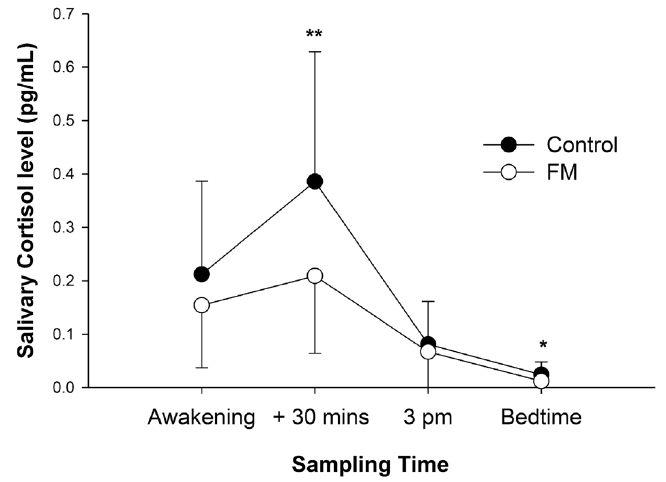
Figure 1. Diurnal salivary cortisol levels. Bars show the mean ± SD; the SD is drawn only in uni-direction. * P < 0.05, ** P =